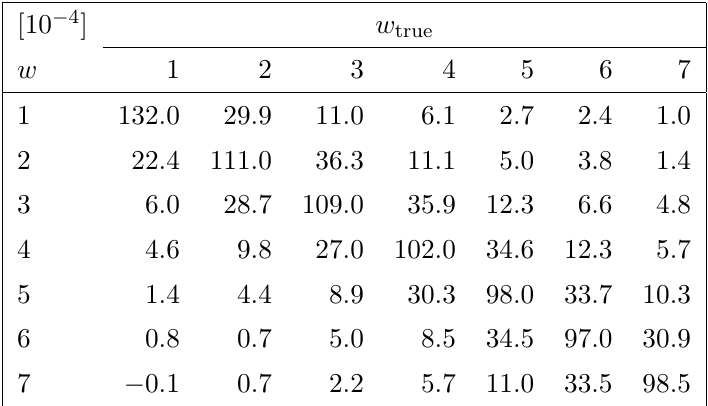
Table 7 . Response matrix, containing the migration from w true to w bins together with the total efficiency in units of 10 − 4